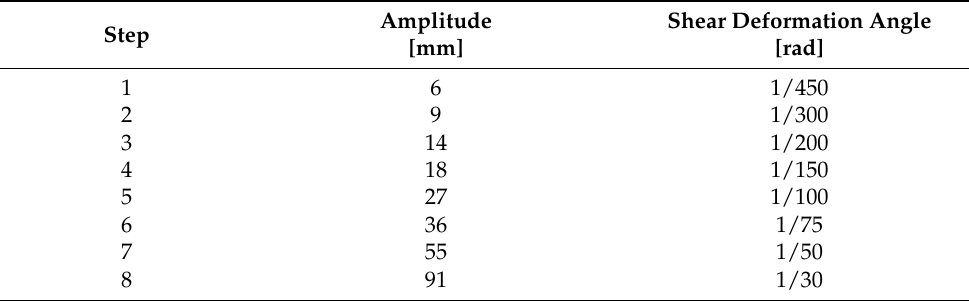
Table 3. Amplitudes of each cyclic